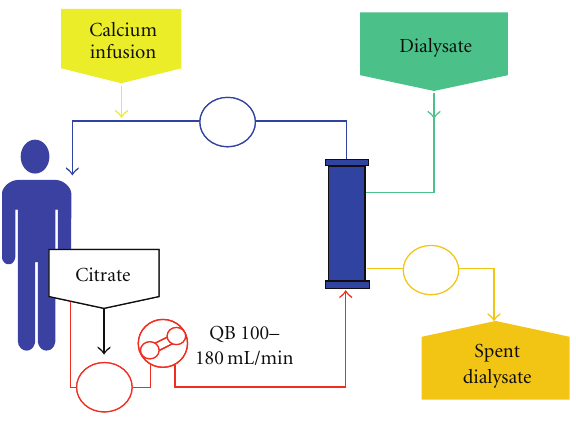
Figure 1: Scheme of standard citrate anticoagulation in